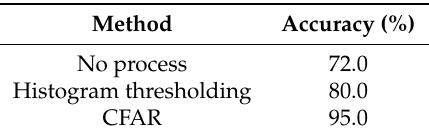
Figure 12. Results of the pose estimation before reconstruction stage; ( a ) Original image slices. ( b ) Results after the pose estimation. Table 2. The accuracy of the coarse pose estimation with different preprocessing method. CFAR: constant false alarm